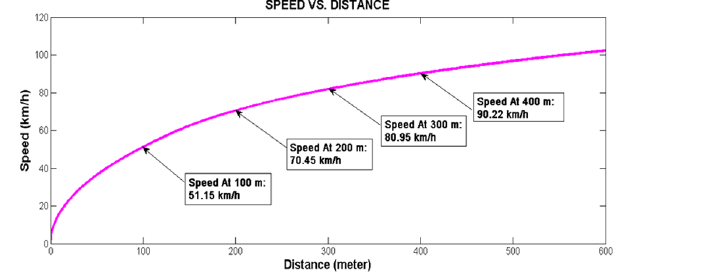
Fig 7. Speed versus distance plot.